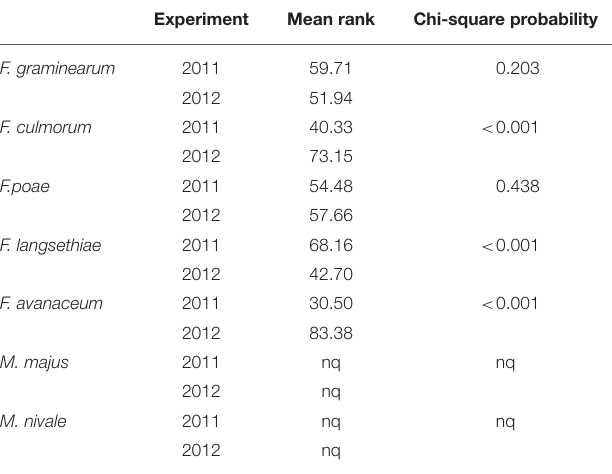
TABLE 4 | DNA of Fusarium spp. and Microdochium spp., described by the mean rank and Chi-square probability, of wheat genotypes assessed in glasshouse experiments in 2011 and